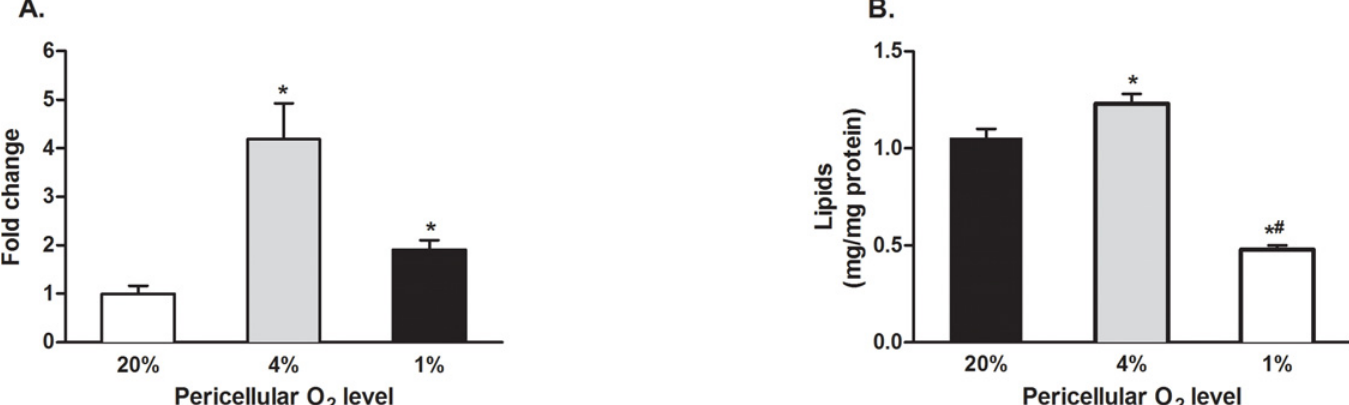
Fig 1. Triglyceride accumulation under exposure to 1%, 4% and 20% O 2 . 3T3-L1 cells were cultured and differentiated under desired O 2 concentrations for 14 days. Lipid accumulation was evaluated using Oil Red O staining. (A) Data are expressed as fold-change relative to a control condition (20% O 2 ), (B) Data are normalized to total protein content. * p < 0.05 for comparison with 20% O 2 .